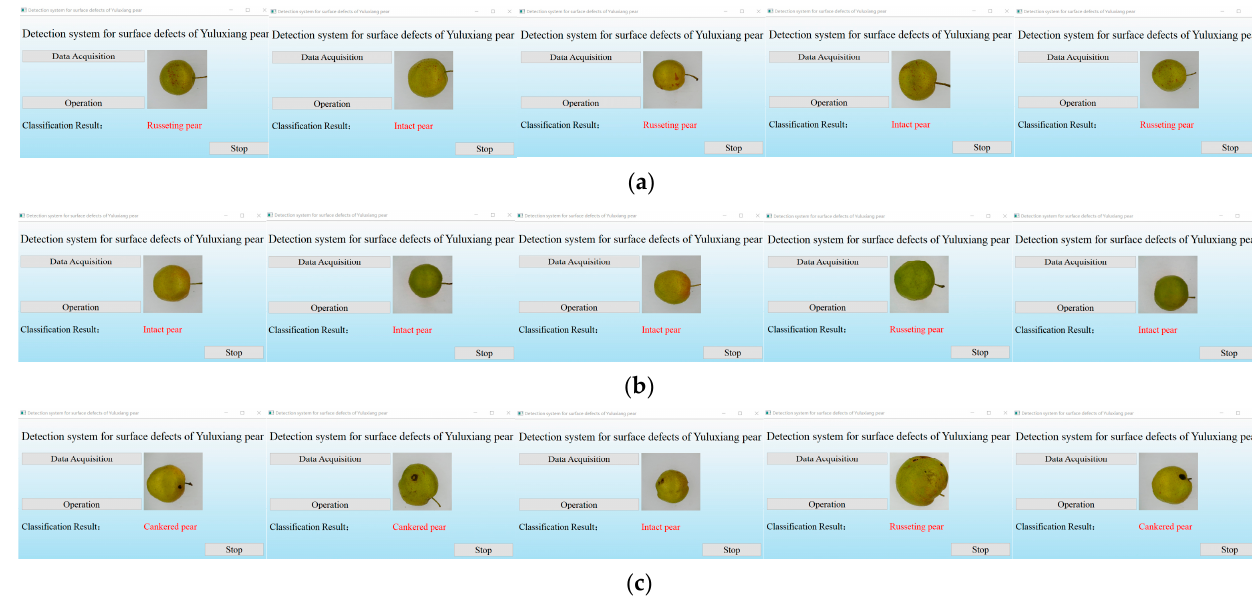
Figure 9. Example of surface defect detection for “Yuluxiang” pear: ( a ) Russeting pears; ( b ) Intact pears; ( c ) Cankered pears.